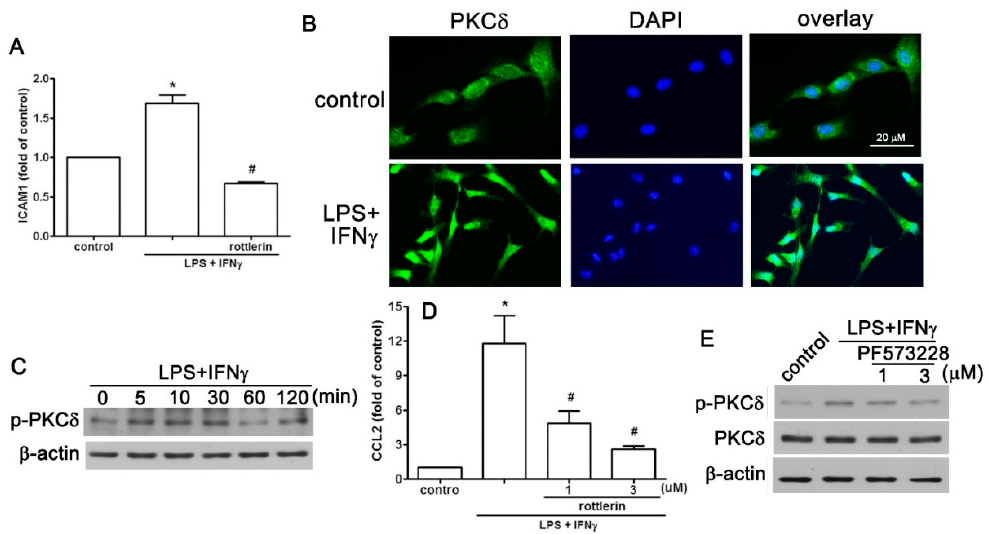
Figure 5. PKC δ translocation is involved in the pro-inflammatory stimuli-associated expression of ICAM1 and CCL2 in human AF cells. ( A ) Cells were treated with the PKC δ inhibitor rotterin for 30 min and stimulated with LPS plus IFN γ for another 24 h. Cell surface ICAM1 was determined using flow cytometry. ( B ) Immunofluorescence staining showed that LPS plus IFN γ stimulation resulted in PKC δ translocation. 4 ′ ,6-Diamidino-2-phenylindole (DAPI) was used as the nuclear counterstain. Scale = 20 μ m. ( C ) Cells were treated with LPS plus IFN γ for 5, 10, 30, 60, or 120 min, and the expression of phosphorylated PKC δ expression was determined using western blot analysis. ( D ) Cells were treated with rotterin for 30 min and stimulated with LPS plus IFN γ for another 6 h, and CCL2 expression was determined using real-time PCR analysis. ( E ) After treating with the FAK inhibitor PF573228, cells were stimulated with LPS plus IFN γ for another 60 min, and the expression of phosphorylated PKC δ was determined using western blot analysis. Quantitative data are presented as the mean ± SEM (representative of n = 3). * p < 0.05 compared with the control group. # p < 0.05 compared with the LPS plus IFN γ treatment group.